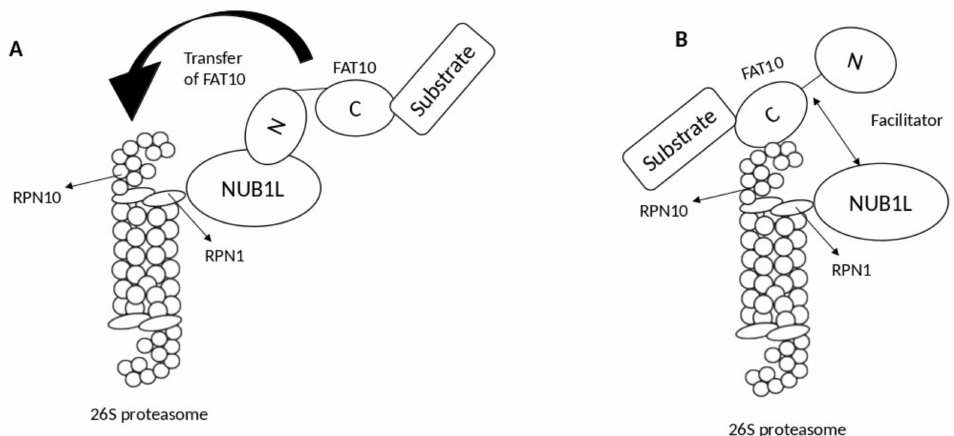
Figure 2. Proposed models show the mechanism of NEDD8 ultimate buster-1 long (NUB1L) in accelerating F-adjacent Transcript 10. (FAT10) degradation by the proteasomal system. ( A ) Model A: the transfer model; NUB1L acts as a receptor and binds to N-terminal of FAT10 and transfer it to ribophorin 10 (RPN10) upon binding to ribophorin 1 (RPN1). ( B ) Model B: the facilitator model; NUB1L acts as a facilitator by binding with RPN1 and later inducing conformational changes within both RPN10 and RPN1 so FAT10 could bind to RPN10, and its degradation can